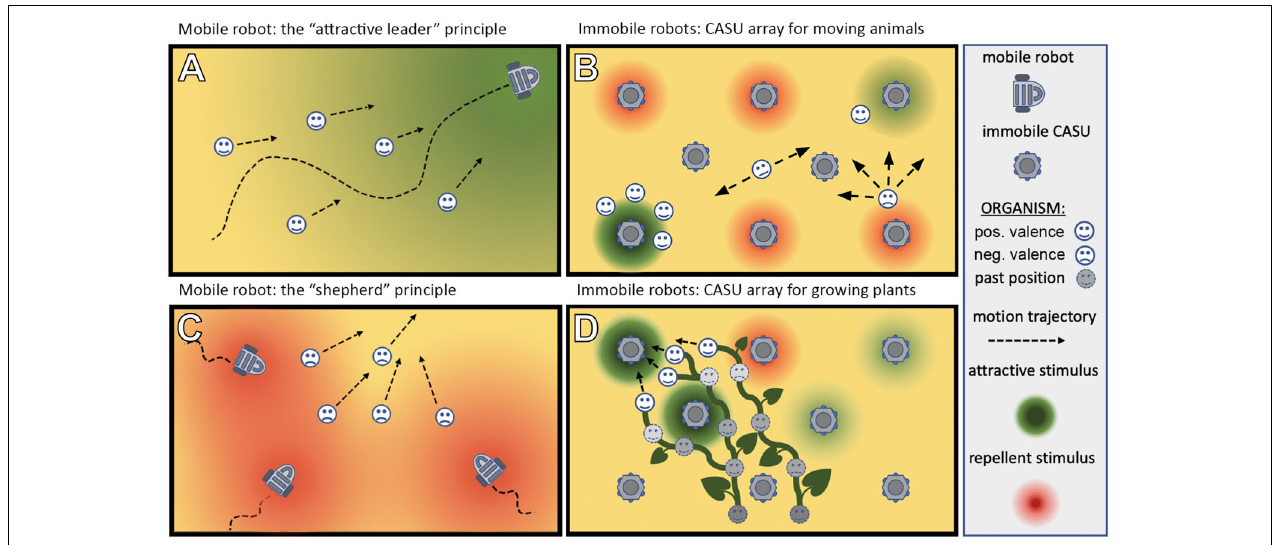
FIGURE 4 | Different types of set-up in which robots can be used to interact with living organisms. (A) A mobile robot can lead the organisms by emitting an attractive stimulus/exhibiting an attractive behaviour. (C) A mobile robot can herd the organisms in a desired direction by emitting a repellent stimulus. (B,D) An array of sensor–actuator nodes (CASUs) can exhibit patterns (either in time or space or both simultaneously) of repellent and/or attractive stimuli to guide organisms [animals (B) or plants (D) ] to a desired place or in a desired